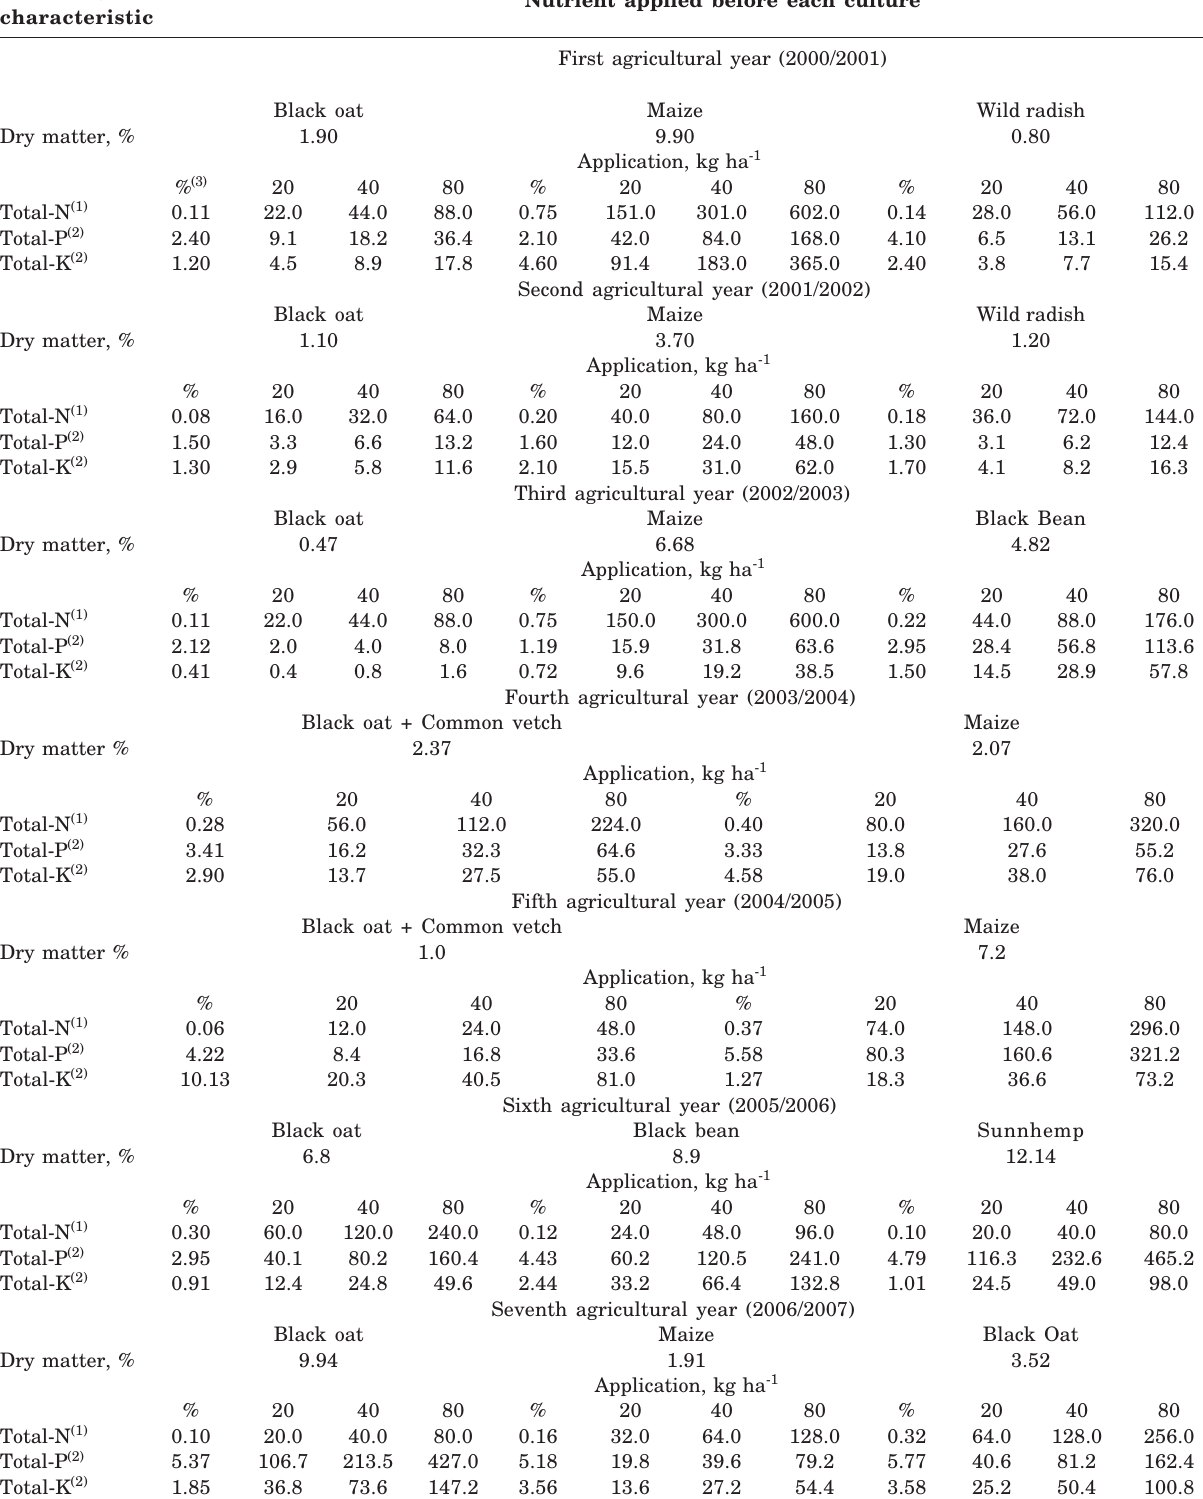
Table 2. Characteristics of pig slurry and nutrient amounts applied before the implementation of each crop in the experimental period of 93